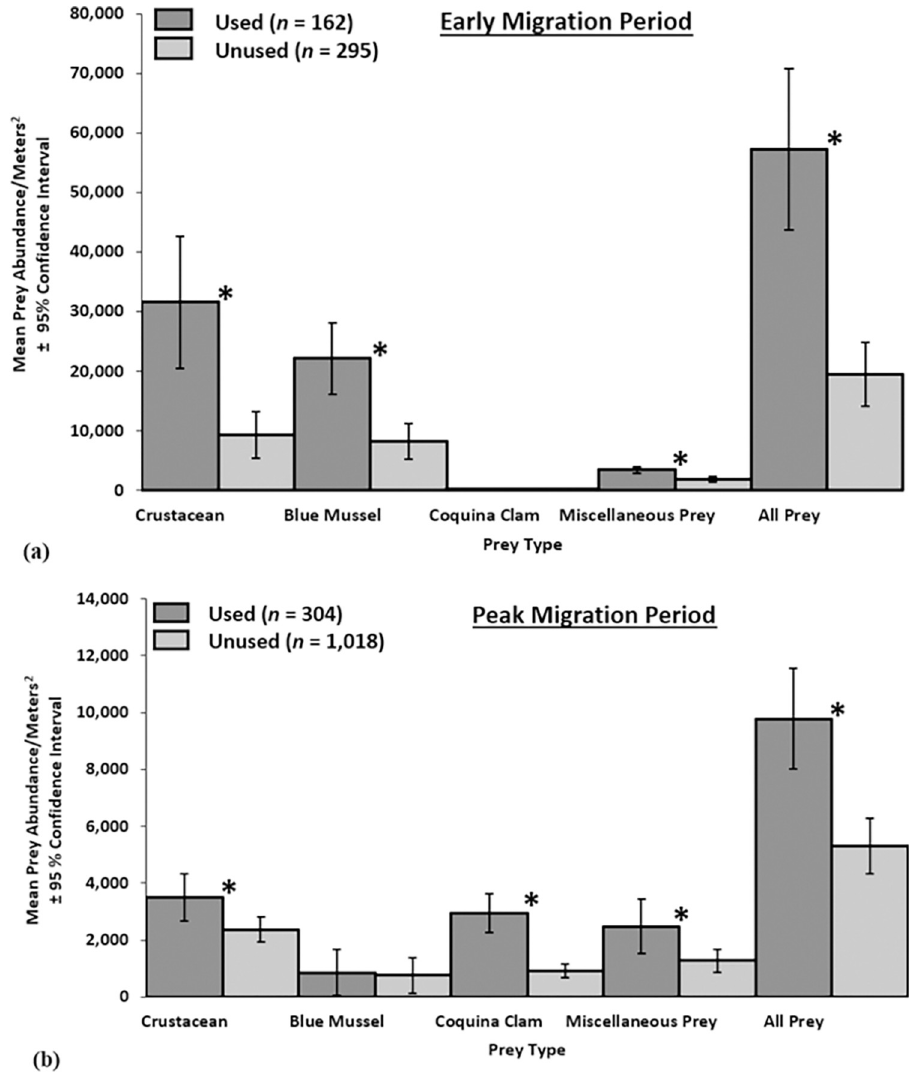
Fig 2. Mean abundance (organisms/m 2 ) of crustaceans, blue mussels, coquina clams, miscellaneous prey, and all prey captured in 10 cm diameter x 3.5 cm deep cores in sites used and unused by red knots. (a) Mean abundance of organisms on peat substrate early in red knot migration (May 14–20, 2008–2018; n = 457; ‘early’) and (b) Mean abundance of organisms on sand and peat substrate at the approximate peak of red knot migration (May 21–27, 2007– 2018; n = 1,322; ‘peak’), Virginia’s barrier islands. � Indicates a difference between used and unused sites (p < 0.05) based on Wilcoxon rank sum tests with Bonferroni